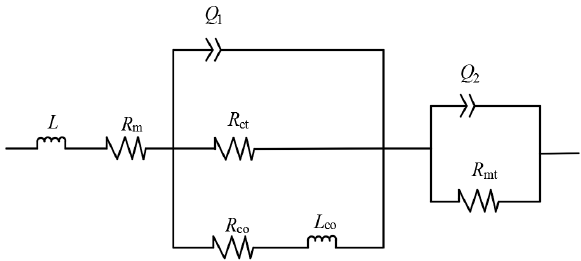
Figure 7. Equivalent circuit (Randles circuit). Table 3. Fitted parameters of the Nyquist plots.